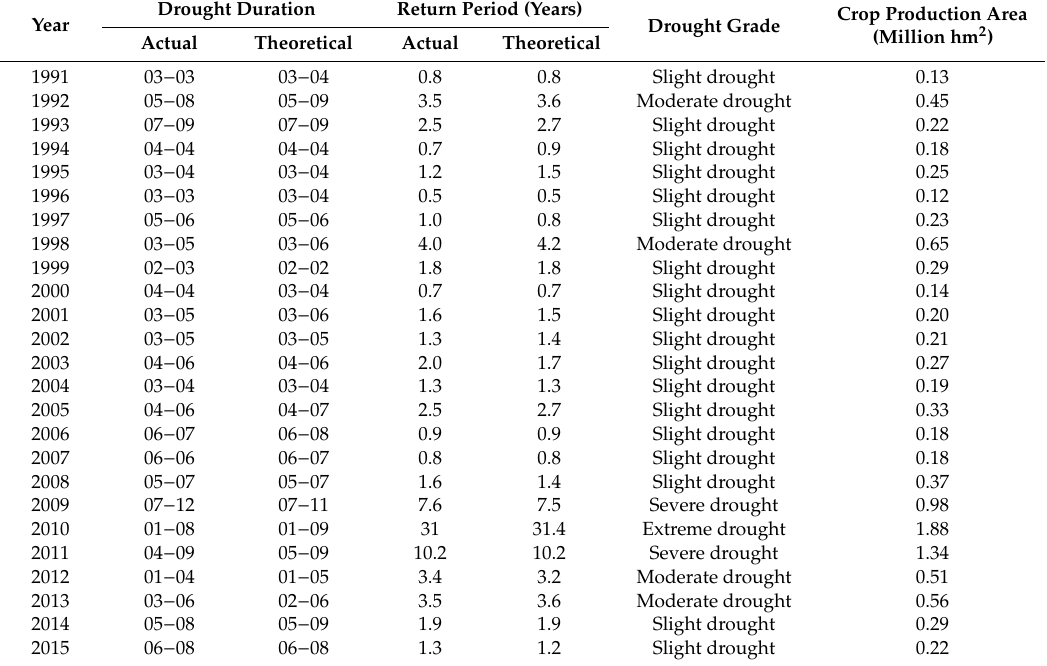
Table 7. Comparison of drought characteristics between theoretical and actual drought events in Lancang from1991 to